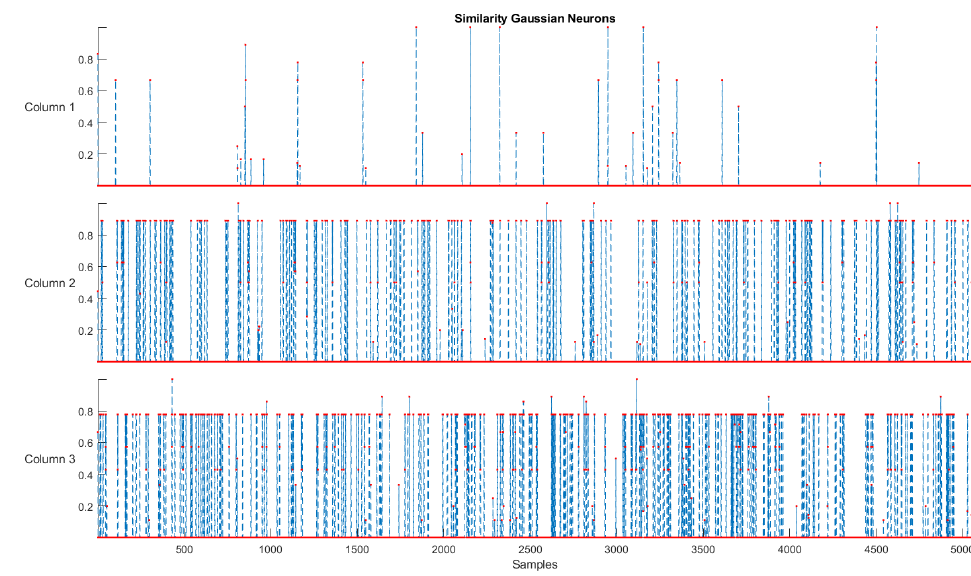
Figure 9. Similarity of Gaussian